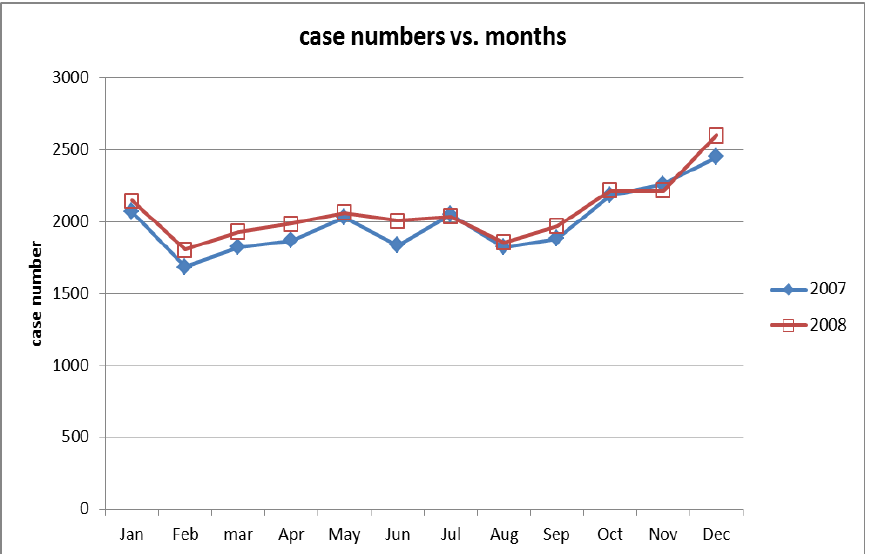
Figure 2. Monthly distribution of case numbers during 2007–2008.